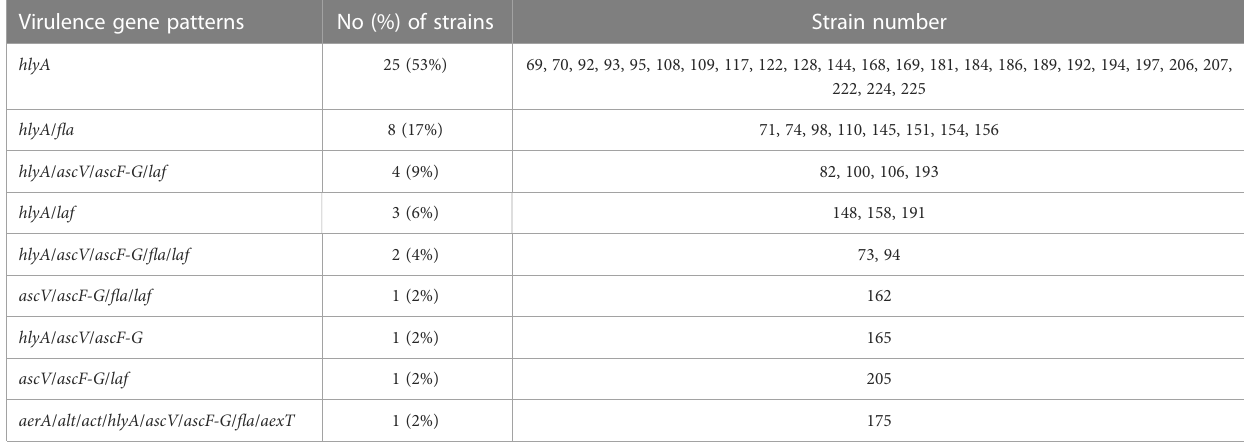
TABLE 3 Virulence gene patterns of 47 A . caviae